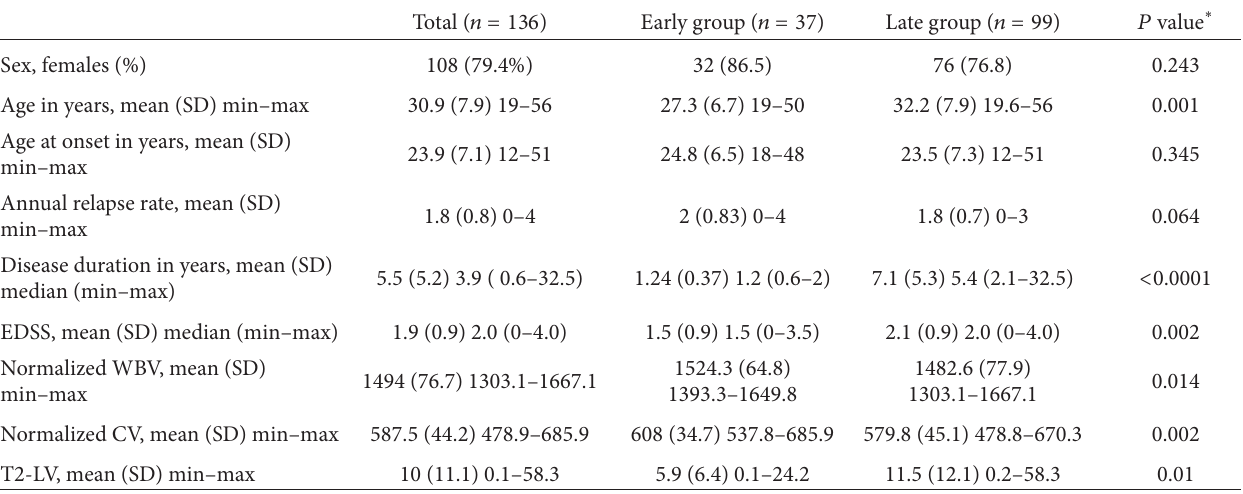
T 1: Descriptive statistics of demographic, clinical, and MRI variables at baseline.